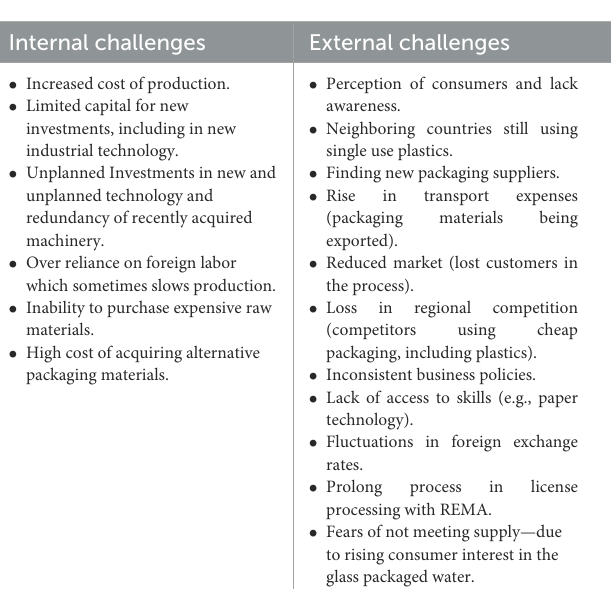
TABLE 4 Challenges firms face as the transition from single use plastics to other